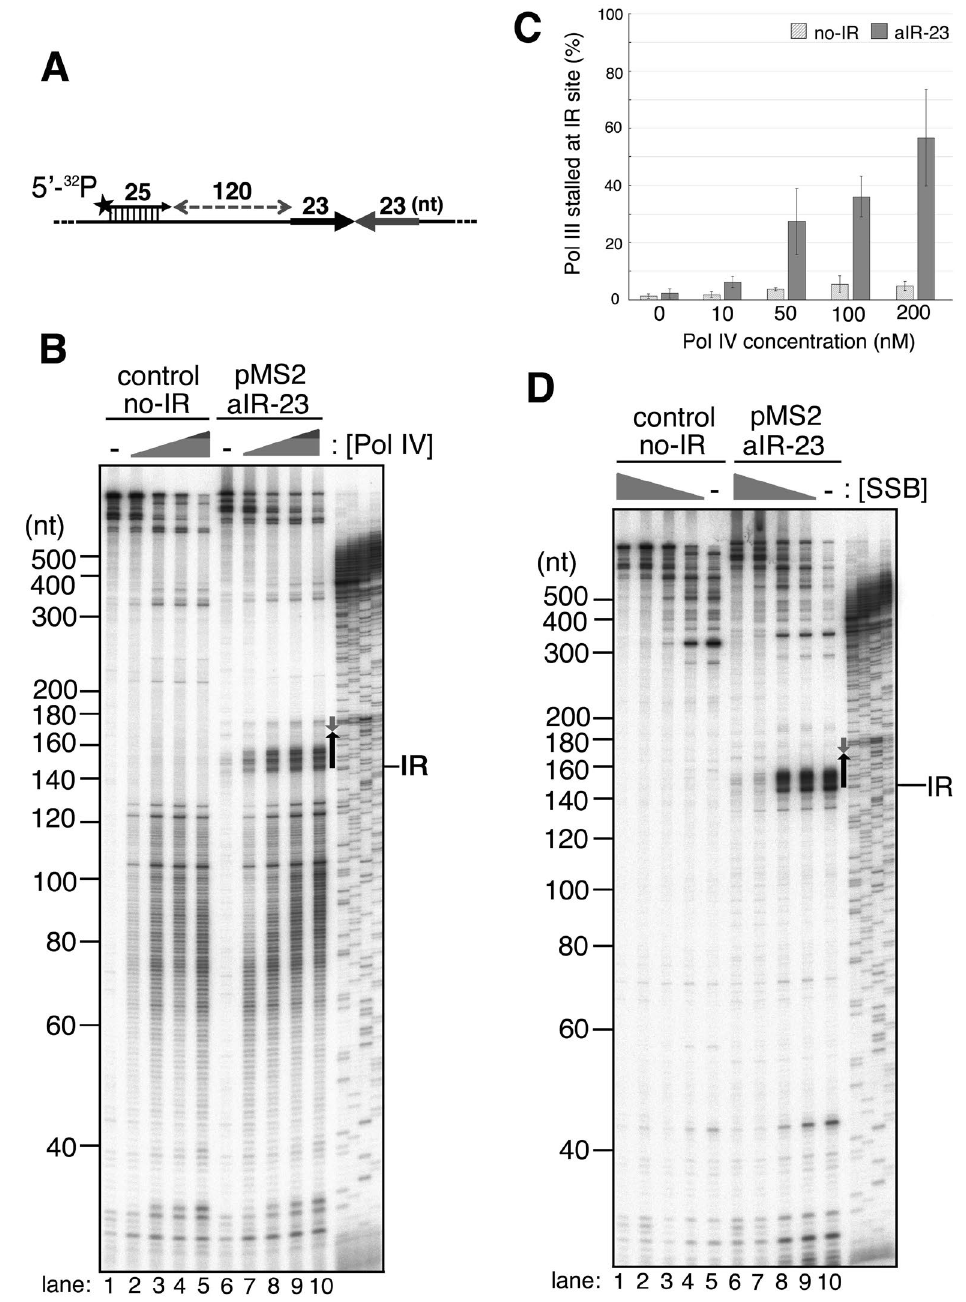
Figure 2. Pol III paused within the inverted repeat sequence in the presence of Pol IV. ( A ). Sketch showing the location of 5 ′ - 32 P labeled primer. Inverted repeat is indicated as black and gray arrows. ( B ). The effect of Pol IV on the primer elongation reaction by Pol III on primed pMS2-aIR-23 template. Wild-type Pol IV (final concentration of 0, 10, 50, 100, and 200 nM) was added together with Pol III HE to the assay using a control, inverted-repeat-free template (pMS2-no-IR, lanes 1–5) or pMS2-aIR-23 template (lanes 6–10). After 3-minute incubation, the elongation reaction was initiated by adding dTTP. Replication products at 10-second incubation were analyzed by 7.5% sequencing gel electrophoresis. Laddering markers representing sequences of pMS2-aIR-23 are shown on the right. Locations of inverted repeats are shown as black and gray arrows in the image. The beginning of inverted repeat in laddering marker is also shown as IR on the right side of the image. ( C ). The effect of Pol IV on ongoing Pol III at the repeat was quantitatively analyzed. The amount of pausing products at the repeat (between ~140 nt and ~191 nt) relative to the amount of products elongated by Pol III ( > 140 nt) in Fig. 2B were quantified and the percentages were calculated. The average percentages of three independent experiments were shown with standard deviations (SD). Note that short laddering signals ( < ~140 nt) were omitted as they were Pol IV-catalyzed products. ( D ). DNA synthesis assay in the absence of Pol IV was carried out to analyze the behavior of Pol III HE at the repeat. Replication products at 10-second incubation in the presence of 0.6, 0.3, 0.15, 0.08, and 0 μ g of SSB were separated on the sequencing gel. (lanes 1–5: no-IR template; lanes 6–10: aIR-23